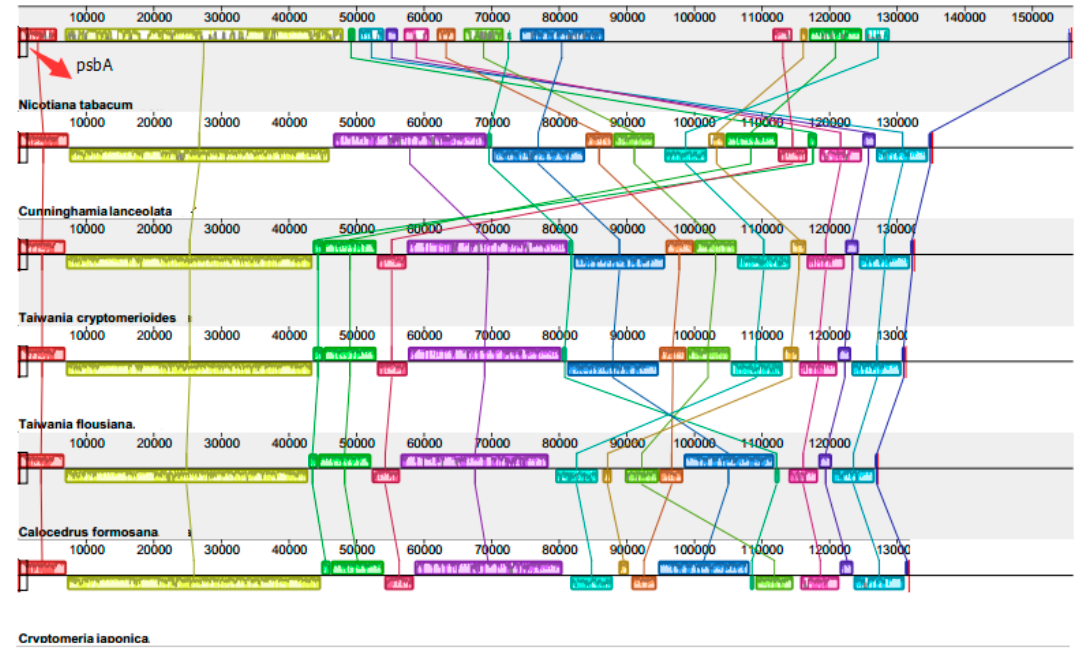
Figure 2. The gene content of five samples in Cupressaceae lineages was visually detected and compared by Mauve [40] with default settings. The colored boxes, which are above and below the middle lines, represent DNA sequences in reverse directions. There were three unique inversions found in the downstream of the gene clusters and evolutionary divergence was shown, although overall the chloroplast genome structure appears to be conserved in the Cupressaceae linage based on the selected plants.